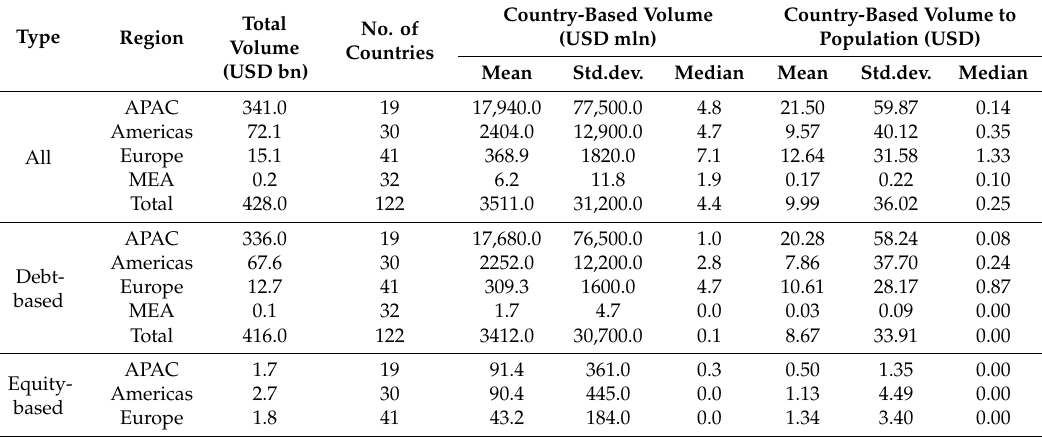
Table 2. Crowdfunding volumes during 2015–2016 across regions and types of